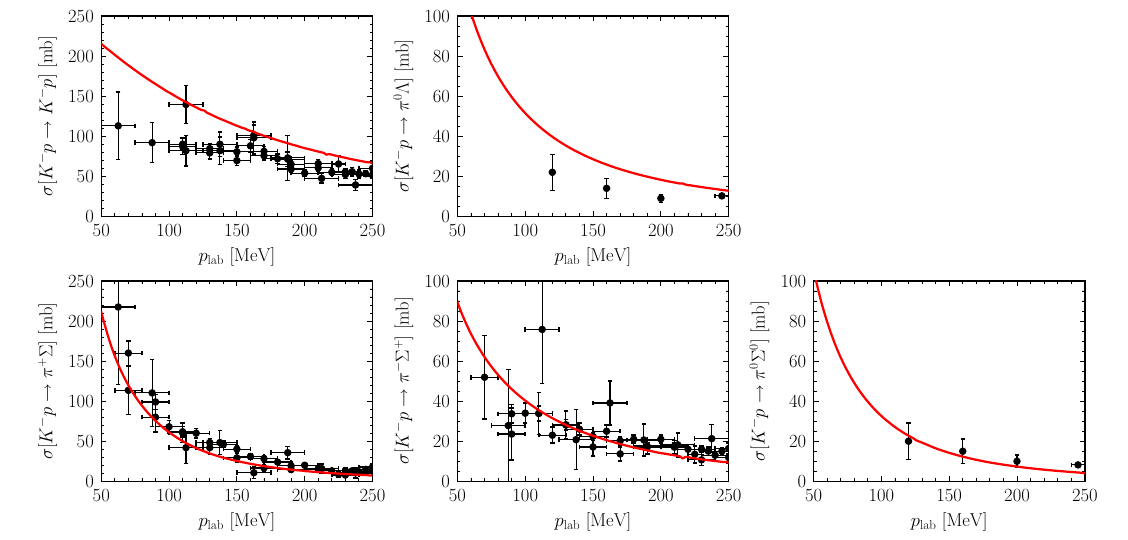
Fig. 4 Total cross section of K − p scattering to various channels as the function of incident K − laboratory momentum p lab . Experimental data are taken from Refs. [11,13,14,80–82]